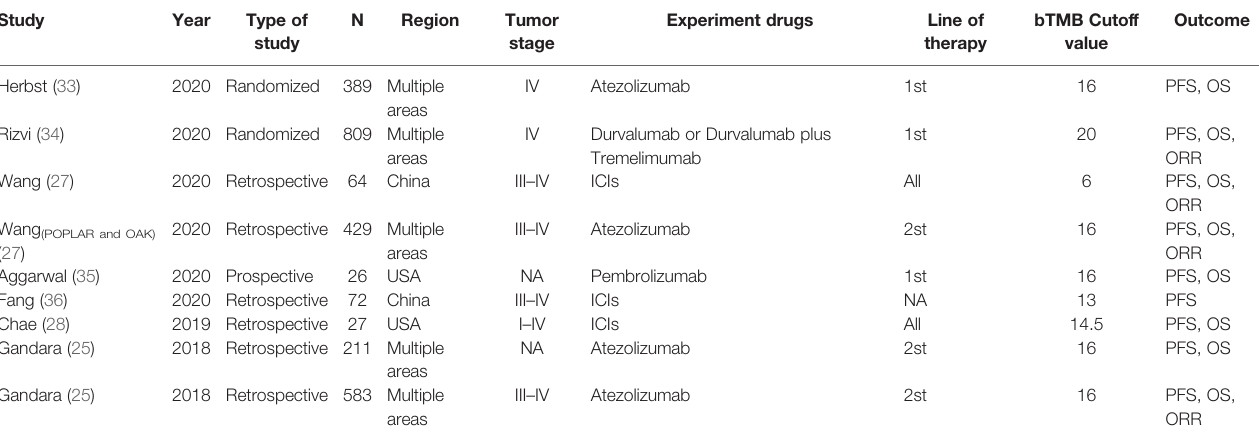
TABLE 1 | The main feature of the studies included in the meta-analysis.